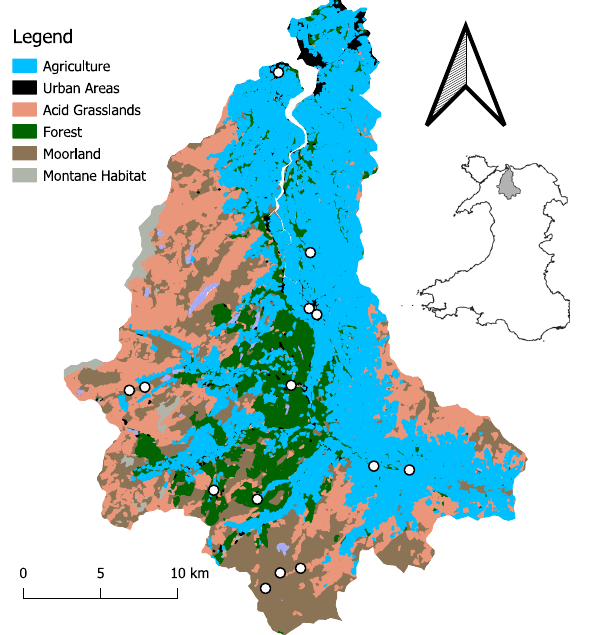
Fig. 1 Map of the study area (Conwy Catchment, North Wales). Colors colors correspond to different landuse types, including agriculture (blue), bog/moorland (brown), acid grassland (pink), forested (green), and urban areas (black). White circles indicate sampling locations ( N =